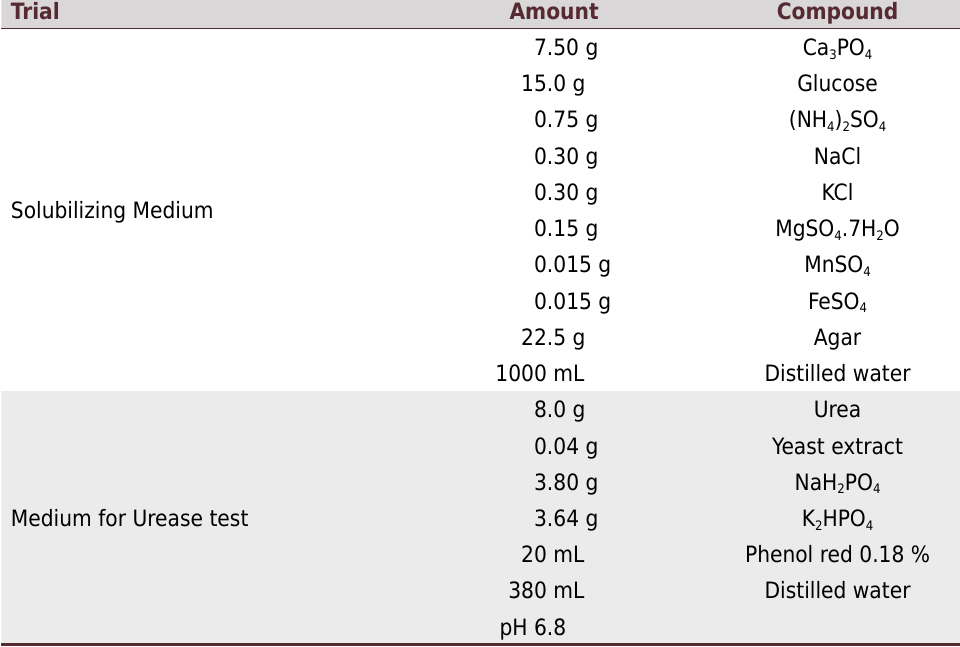
Table 3. Solubilizing and urease media